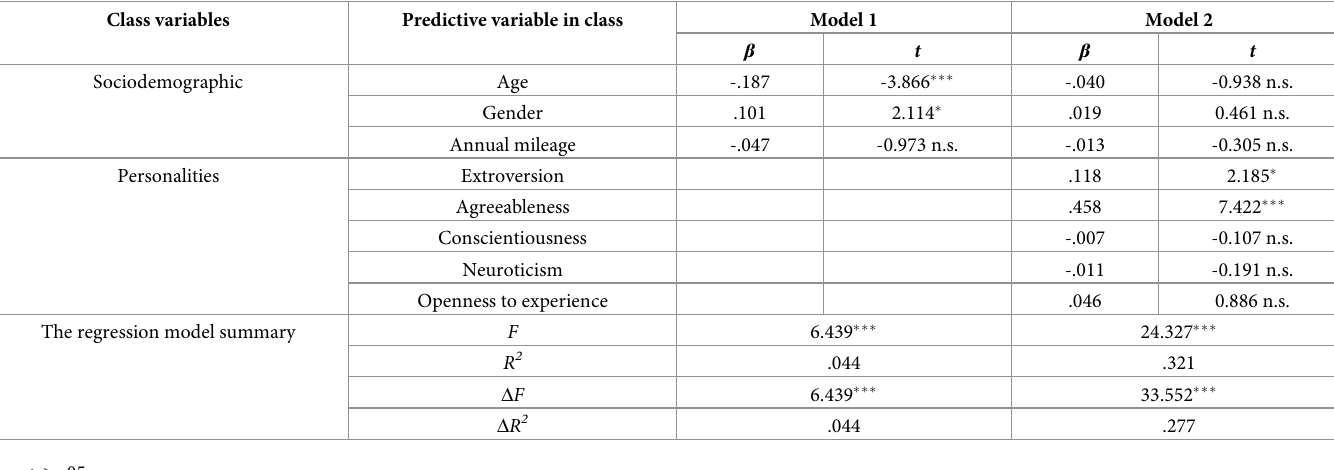
Table 4. Hierarchical regression models of full